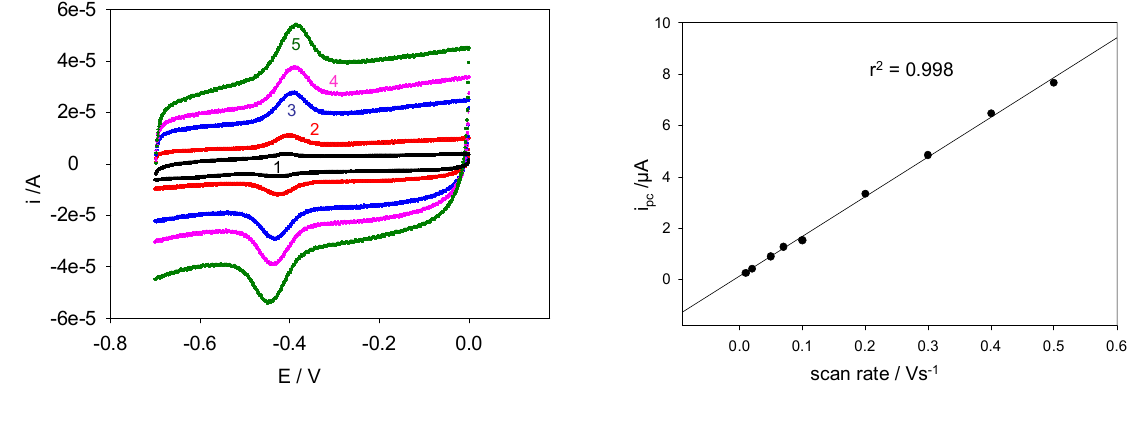
Figure13. (a) Cyclic voltammograms obtained using a SWCNT/GOx-modified Au working electrode. The electrolyte used was a 50 mM PBS (pH 7). The scan rates shown are (1) 0.1, (2) 0.3, (3) 0.8, (4) 1.1 and (5) 1.5 Vs -1 . (b) The variation of cathodic peak current with scan rate using a